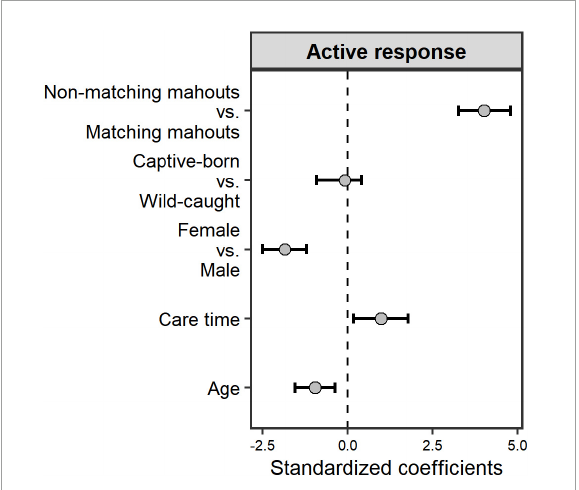
FIGURE2 The impact of the predictors (voice source and elephant individual traits) on the active response of the elephants. Grey dots and black whiskers represent the standardized coefficient with 95% confidence